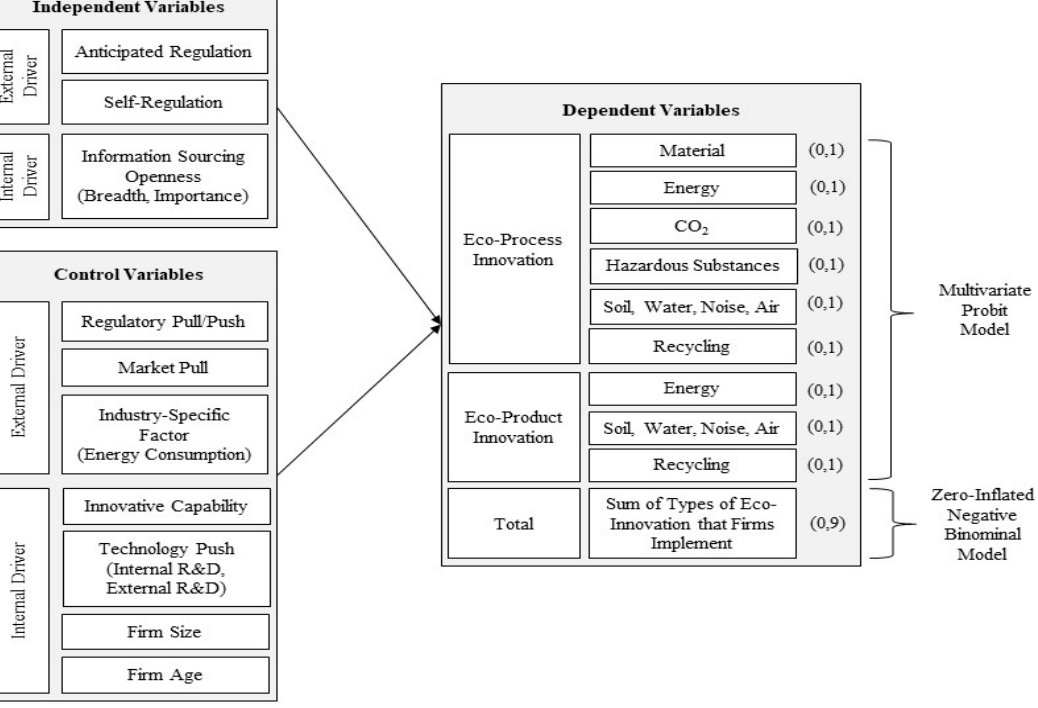
Figure 1. Research Model.